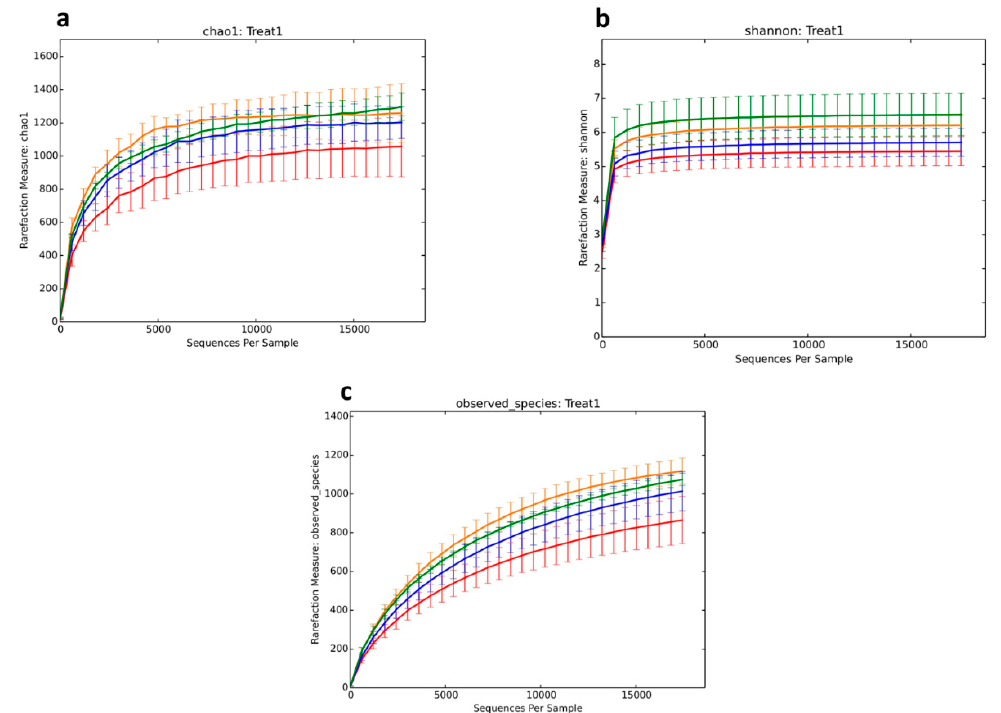
Figure 3. Alpha diversity rarefaction plots of Chao1, Shannon, and observed species. Note: red = alfalfa, blue = cornstalk, orange = rice straw, and green = control. The abscissa represents the total number of randomly extracted sequences in each sample, and the ordinate represents the number of OTUs observed at the corresponding depth. The length of the curve reflects the amount of sample sequencing. The longer the curve, the higher the sequencing depth and the greater the possibility of observing higher diversity.